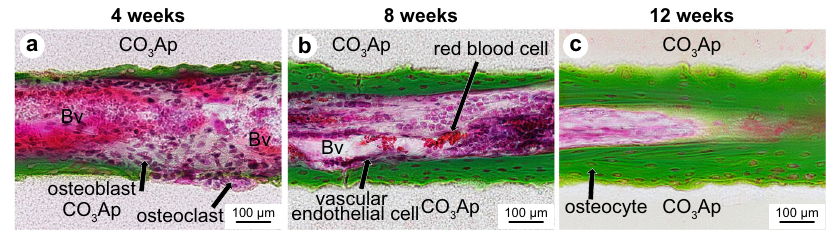
Fig. 8 High-magni fi cation images displaying the Villanueva Goldner staining of CO 3 Ap HCBs. At 4 ( a ), 8 ( b ), and 12 weeks ( c ) after implantation. Blood vessels (Bv) were found in the pores of CO 3 Ap area and residual CO 3 Ap area. Percentage of new bone and residual CO 3 Ap 2, 4, and 8 weeks after implantation ( a ). * p < 0.05. Percentage of new bone and residual CO 3 Ap 2, 4, and 8 weeks after implantation in the central part (C) and in the lateral parts at both ends (L) ( b ). * p <